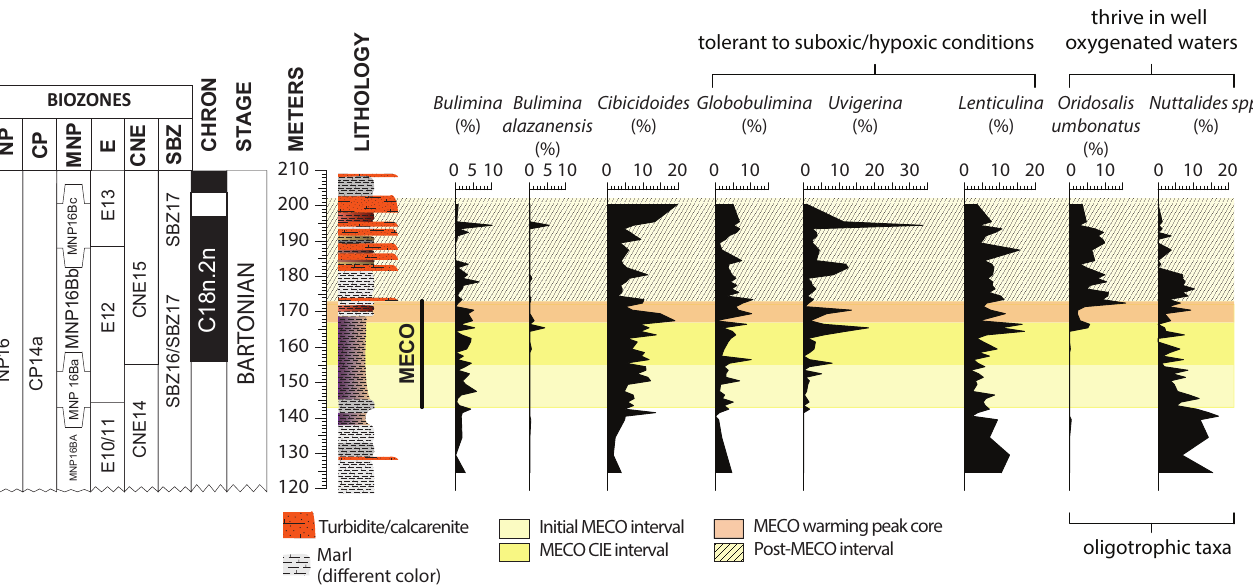
Figure 4. Benthic foraminiferal relative abundance of selected genera and species. The main ecological preferences are also indicated (see text for explanations). Magneto-biostratigraphy and lithostratigraphy as in Figure